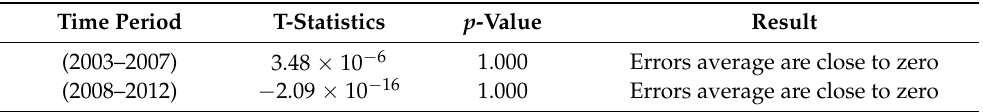
Table 11. The results of the Student’s t